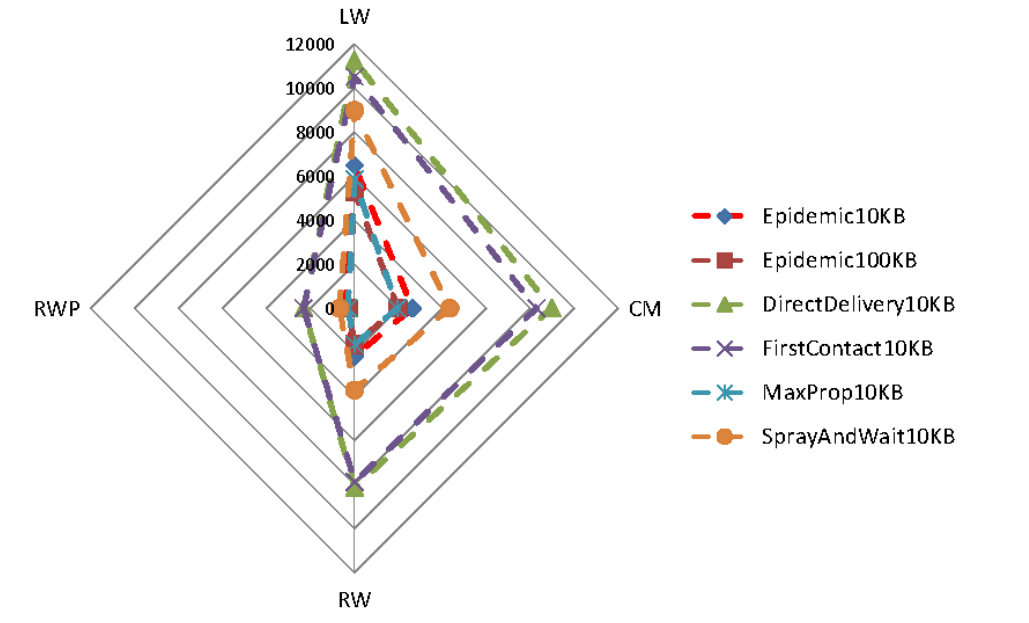
Figure 12. Delay with different mobility models, 40